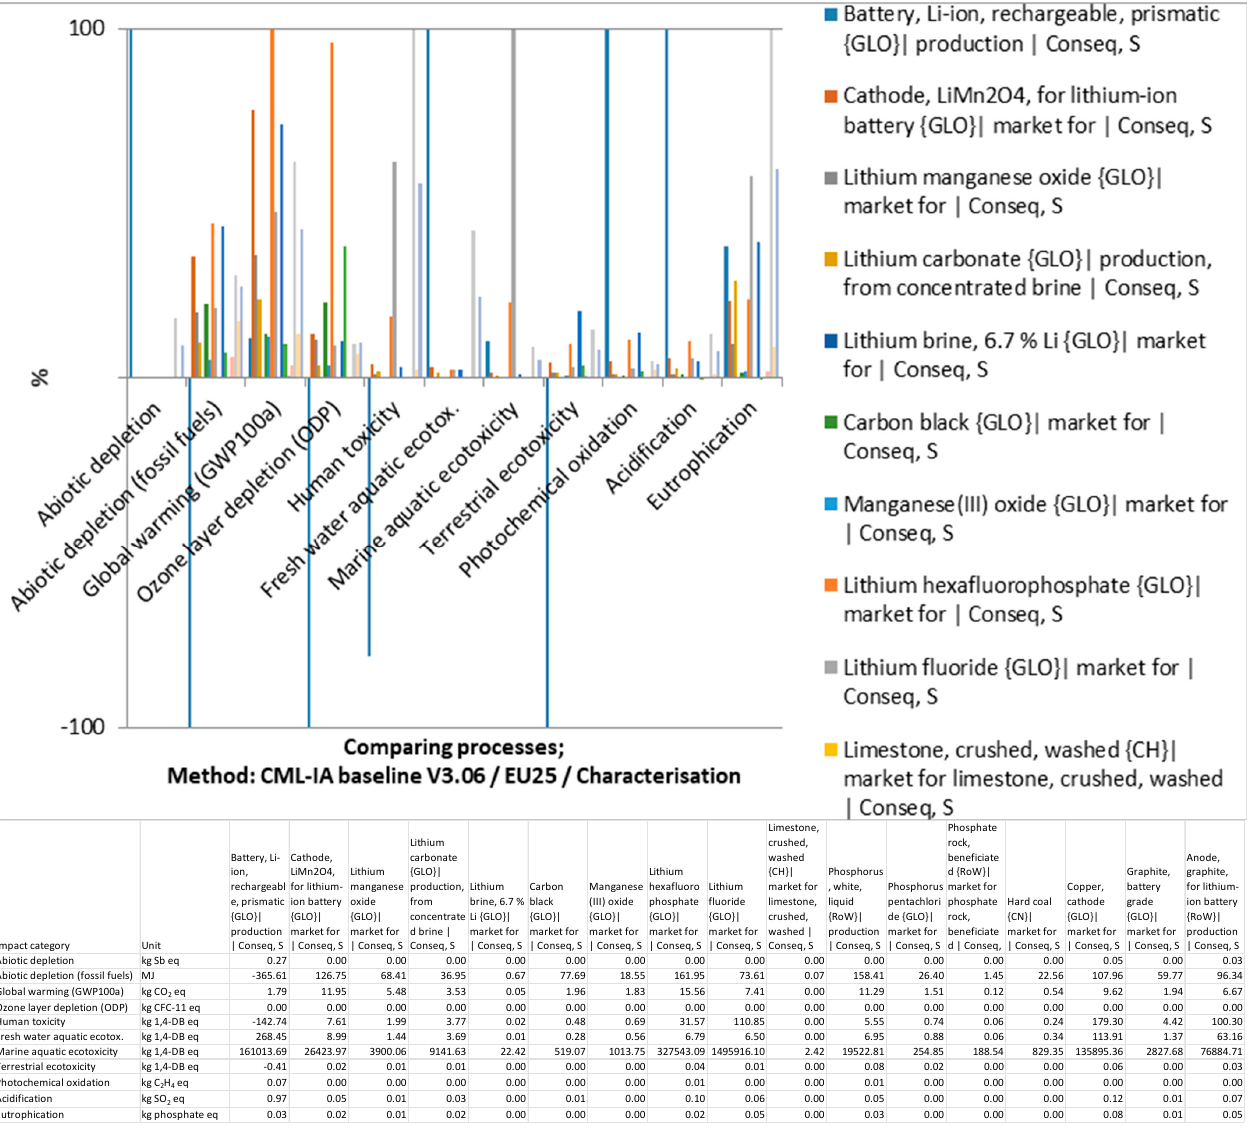
Figure 6. CML life cycle impact characterisations of 1 kg of each key material shown in Table 1.